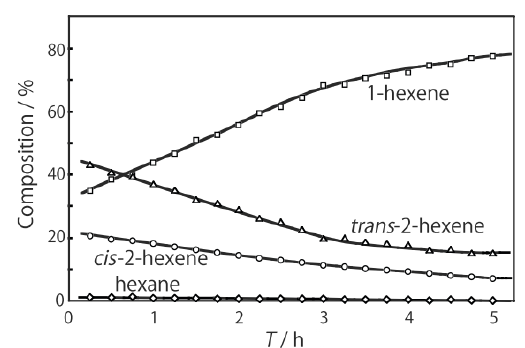
Figure 11. Typical reaction profile of 1-hexene under hydrogen over [(Nb Following activation of the cluster (30 mg, 25 μmol) in a hydrogen stream (2.4 L/h) at 350 °C for 1 h, reaction was initiated by introduction of 1-hexene (0.8 mL/h, 7.1 mmol/h) to the hydrogen stream without changing the